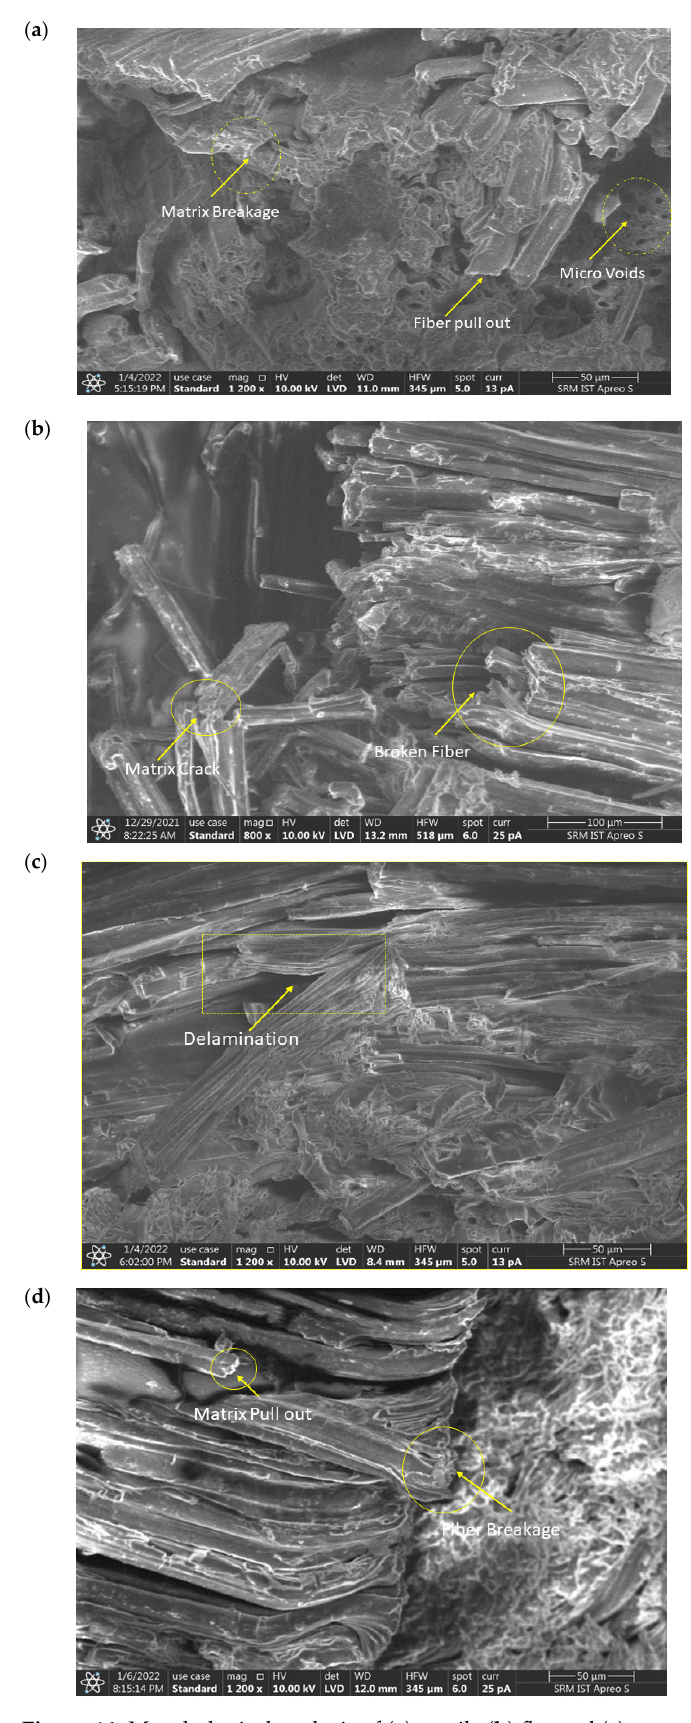
Figure 14. Morphological analysis of ( a ) tensile ( b ) flexural ( c ) compressive and ( d ) impact specimen.